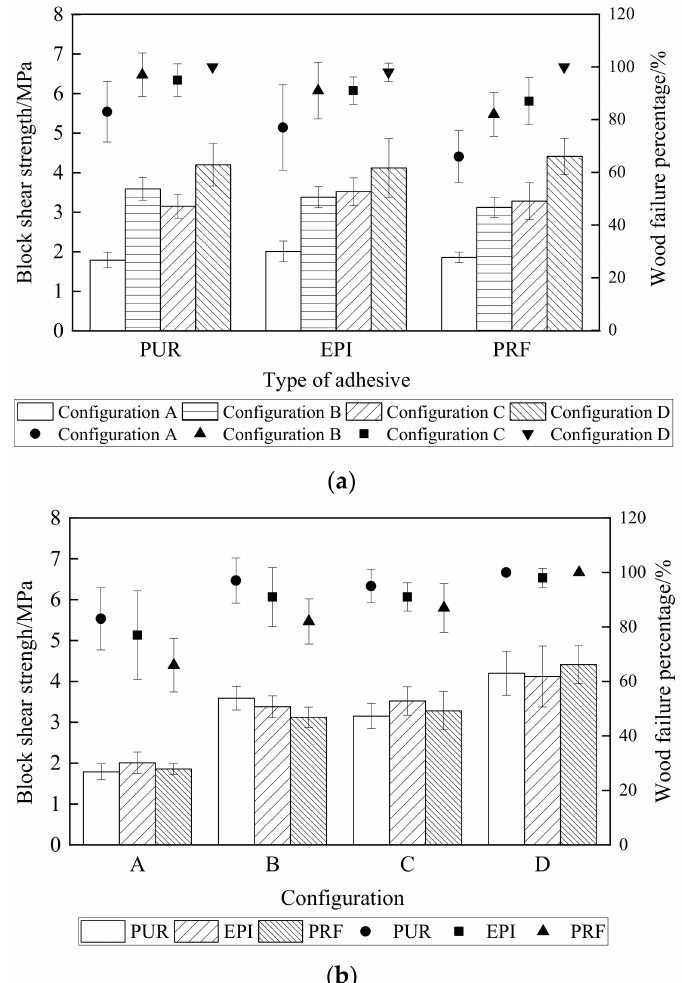
Figure 4. BSS and WFP of CLT and HCLT specimens at dry condition: ( a ) Influence of configuration, and ( b ) Influence of